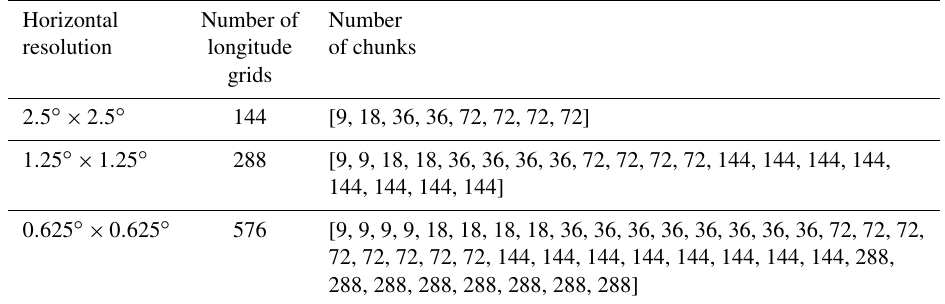
Table 2. The ring average setup for different TIEGCM horizontal resolutions (column 1) associated with the number of longitude grids (column 2) and the number of averaging chunks in each azimuthal ring near the pole (column 3).